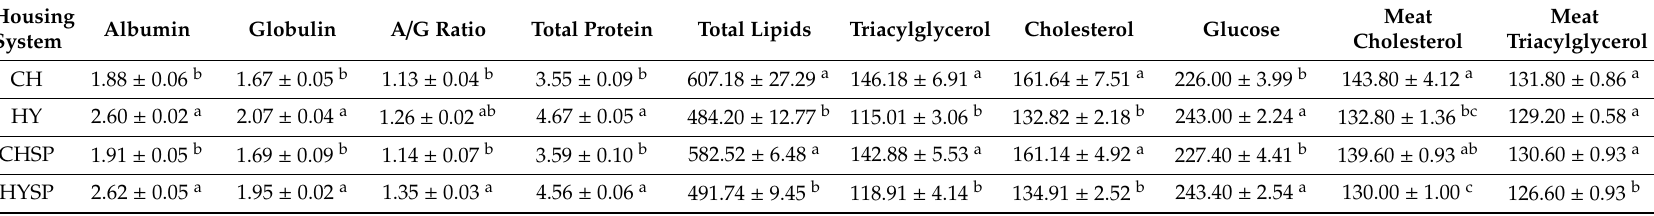
Table 3. E ff ect of di ff erent housing systems on blood biochemical parameters (mg / dL) and meat cholesterol and triacylglycerol (mg / dL of extract) of Pekin ducks.